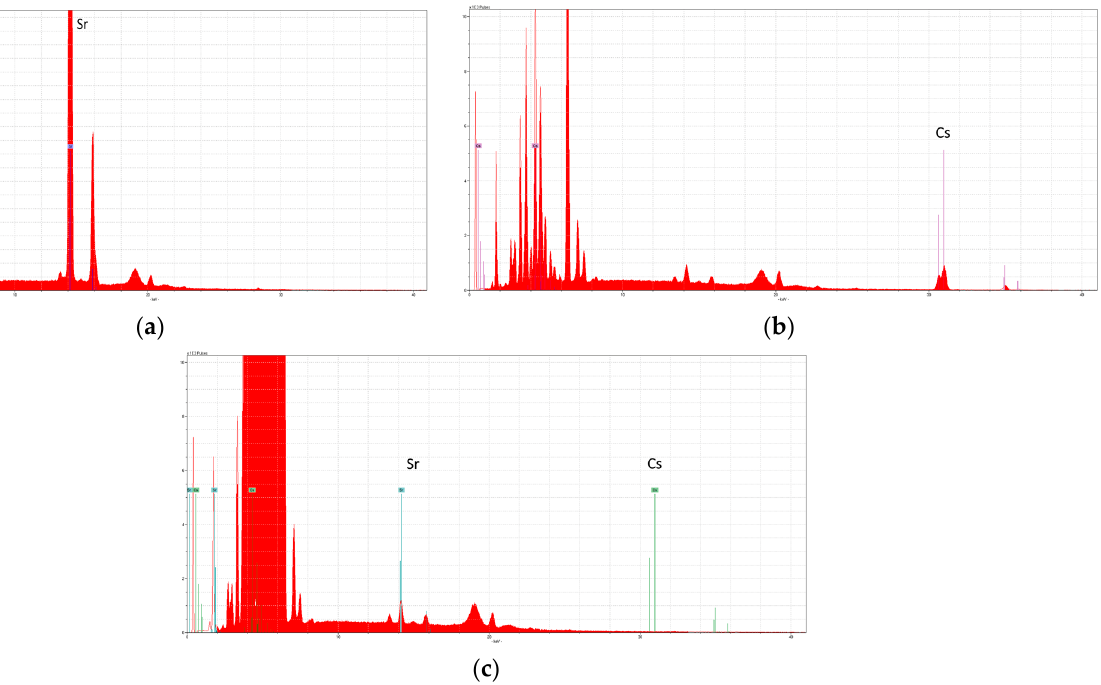
Figure 6. XRF spectra of zeolite after the sorption of Sr 2+ ( a ), after the sorption of Cs + ( b ), and before the sorption experiments ( c ).